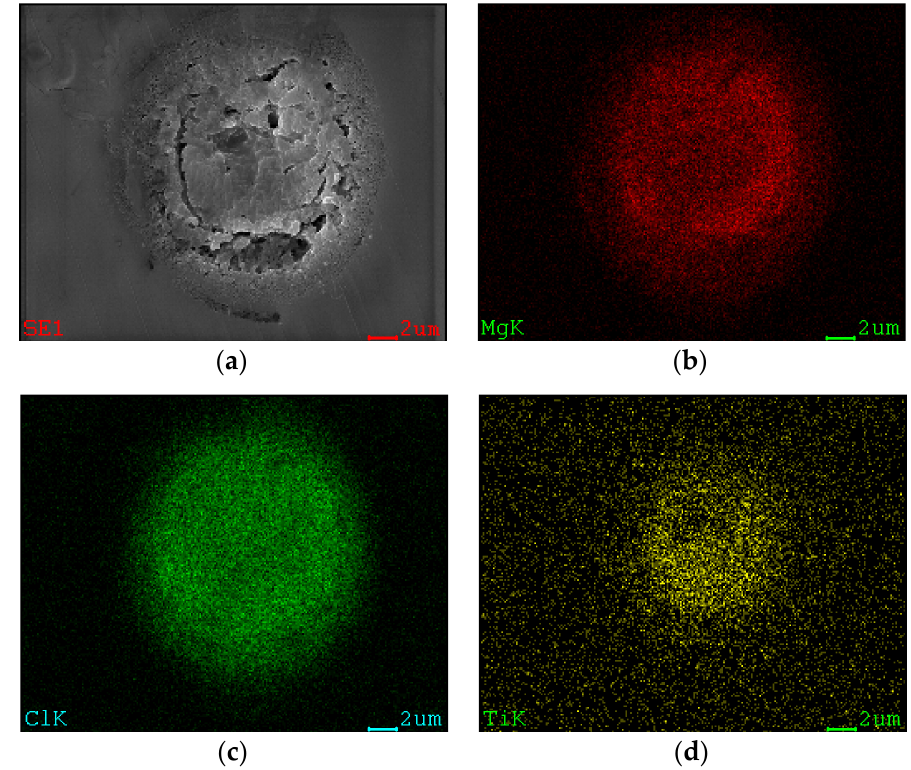
Figure 8. Energy dispersive X-ray results for the catalyst. ( a ) The SEM image of the total area; ( b ) EDS mapping of Mg element; ( c ) EDS mapping of Cl element; ( d ) EDS mapping of Ti